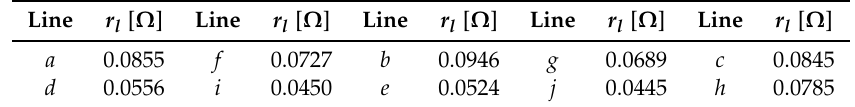
Figure A1. Electrical configuration for the 6-nodes test system used in the GAMS example. Table A1. Branches information.